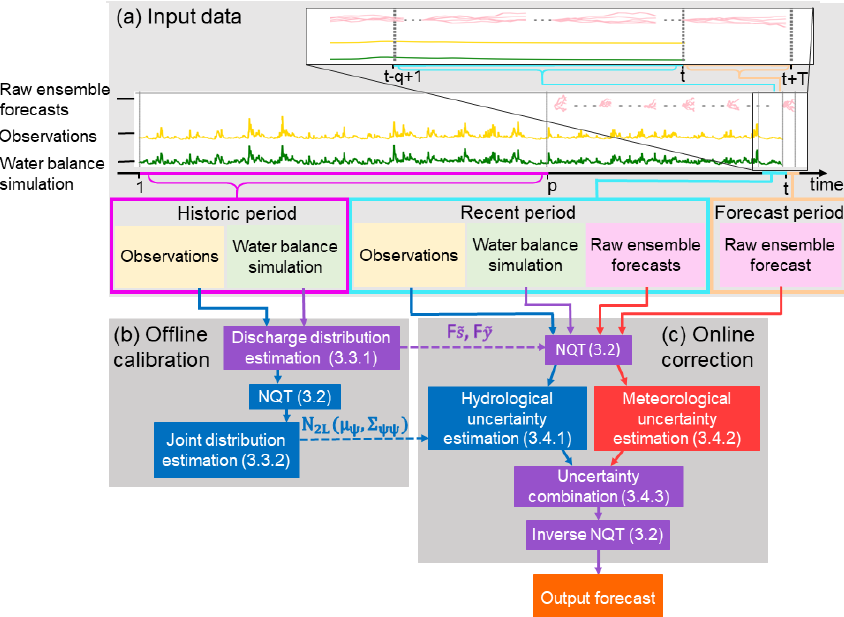
Figure 1. Flow chart describing the post-processing method at a station. (a) Input data are separated by time period (historic period: fuchsia, recent period: cyan, forecast period: peach) and by data type (observations: yellow, water balance simulations: green, raw ensemble forecasts: pink). The top time series is a magnification of the bottom time series for the period t − q + 1 to t + T . The historic period has length p . For a forecast produced at time t , the recent period starts at time t − q + 1 and the forecast period ends at time t + T . (b) Offline calibration steps. (c) Online correction steps. NQT is the normal quantile transform. Blue and red arrows and boxes show the data and methods used to account for the hydrological uncertainty and the meteorological uncertainty, respectively. Data and methods used to account for both the hydrological and meteorological uncertainties are shown in purple. Dashed arrows show data stored in the station model such as the cumulative distribution functions of the water balance simulation and observations, denoted F ˜ s and F ˜ y , respectively, and the joint distribution between the water balance simulation and observations, denoted N 2 L ( µ ψ , (cid:54) ψψ ) . Section numbers given in parentheses contain more